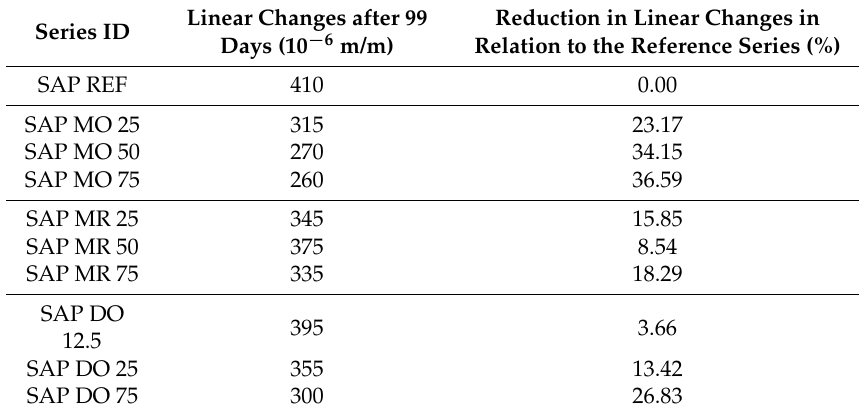
Table 8. Percentage reduction in average linear changes in relation to the reference series on day 99 from specimen